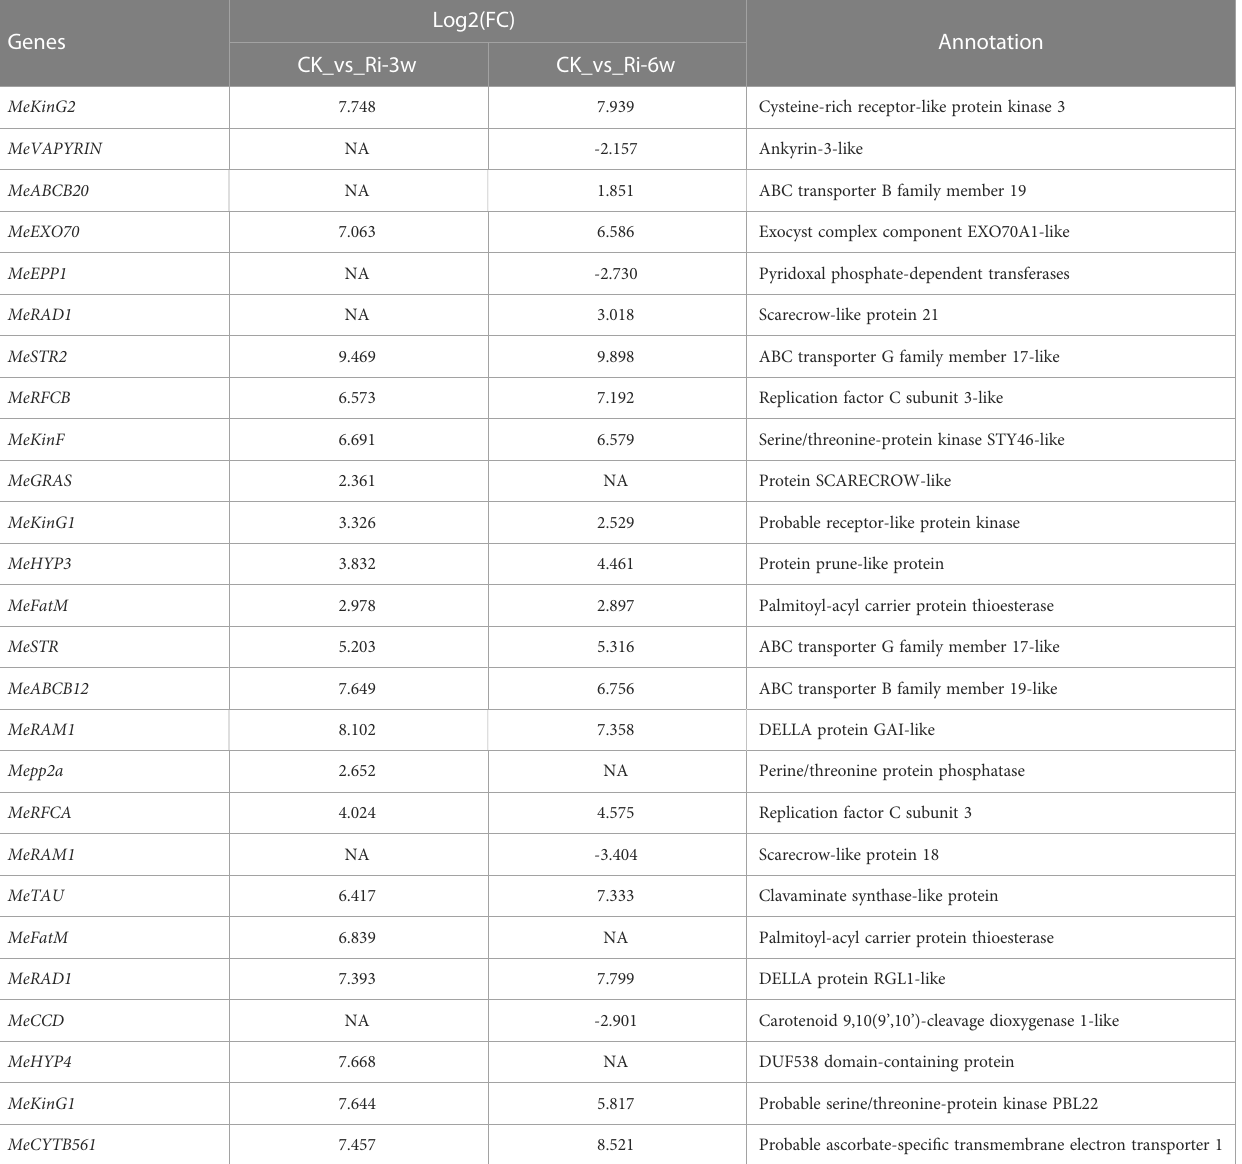
TABLE 2 DEGs related to the SYM signaling pathway in cassava.